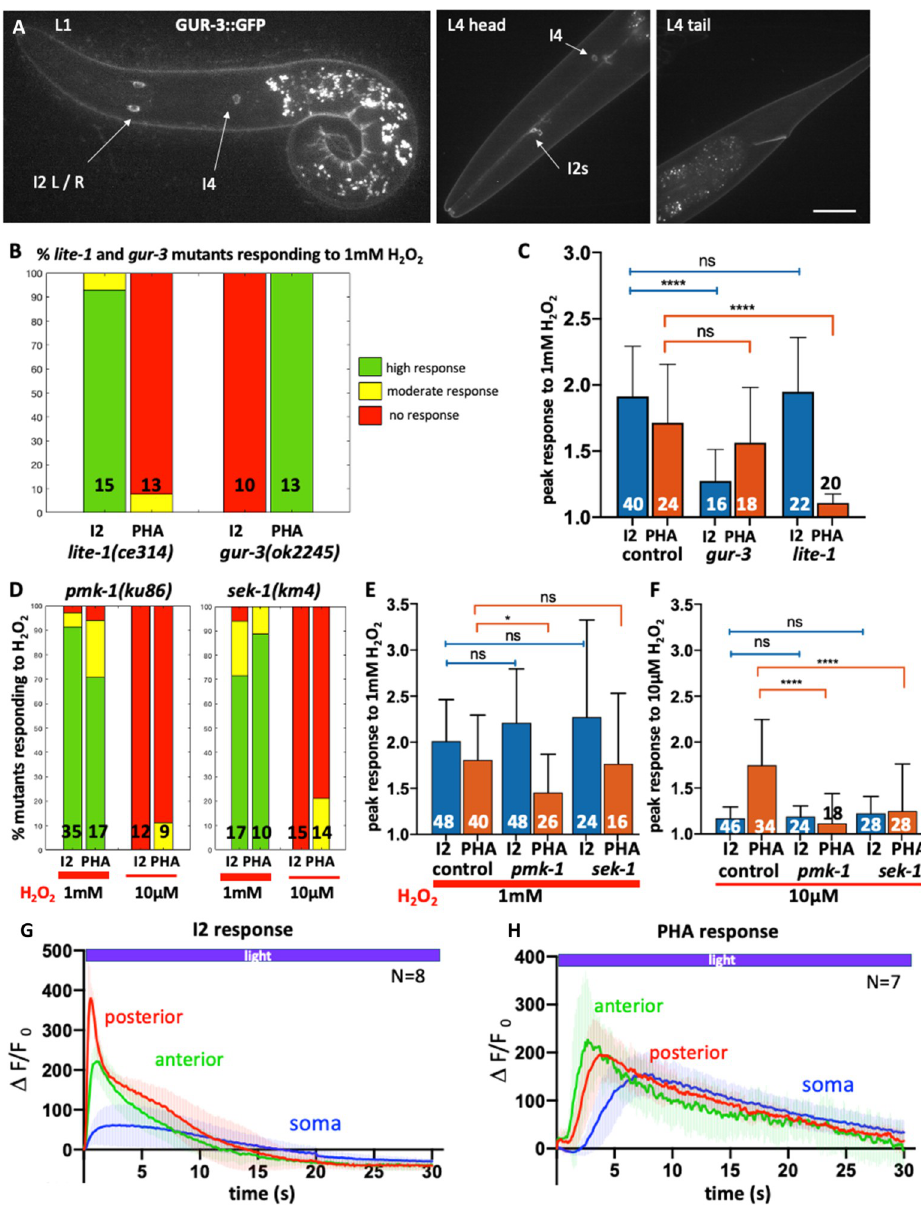
Fig 4. H 2 O 2 response involves different receptors and transducers in I2 and PHA neurons. (A) Spinning-disc confocal projections of a representative GUR-3::GFP knock-in animal, at L1 (left) and L4 stages (right). The GUR-3:: GFP signal is detected in I2 neurons and in a single I4 neurons (head panel), but not in PHA/PHB neurons (tail panel). Bar, 10 μ m. (B,D) Bar graph of the fraction of lite-1 , gur-3 , pmk-1 and sek-1 mutants responding to the H 2 O 2 stimulation, classified as high (green), moderate (yellow) or absent (red) responses. N, number of movies analyzed. (C, E,F) Quantification of the calcium response to 1mM H 2 O 2 in I2 and PHA neurons in controls and in gur-3 and lite-1 mutants (C), and in pmk-1 and sek-1 mutants at 1mM (E) and at 10 μ M H 2 O 2 (F). Bars represent the mean (number of movies indicated) and error bars SD; ns, not significant, p > 0.05; � p < 0.05; ���� p < 0.0001 (ANOVA and Kruskal-Wallis tests). See corresponding S8–S19 Movies and S7–S10 Figs. (G,H) Blue light triggered different calcium fluxes in I2 and PHA neurons in the three regions analyzed; anterior neurite (green), posterior neurite (red) and soma (blue). The curves represent the mean and shaded error bars indicate SD. See S20–S22